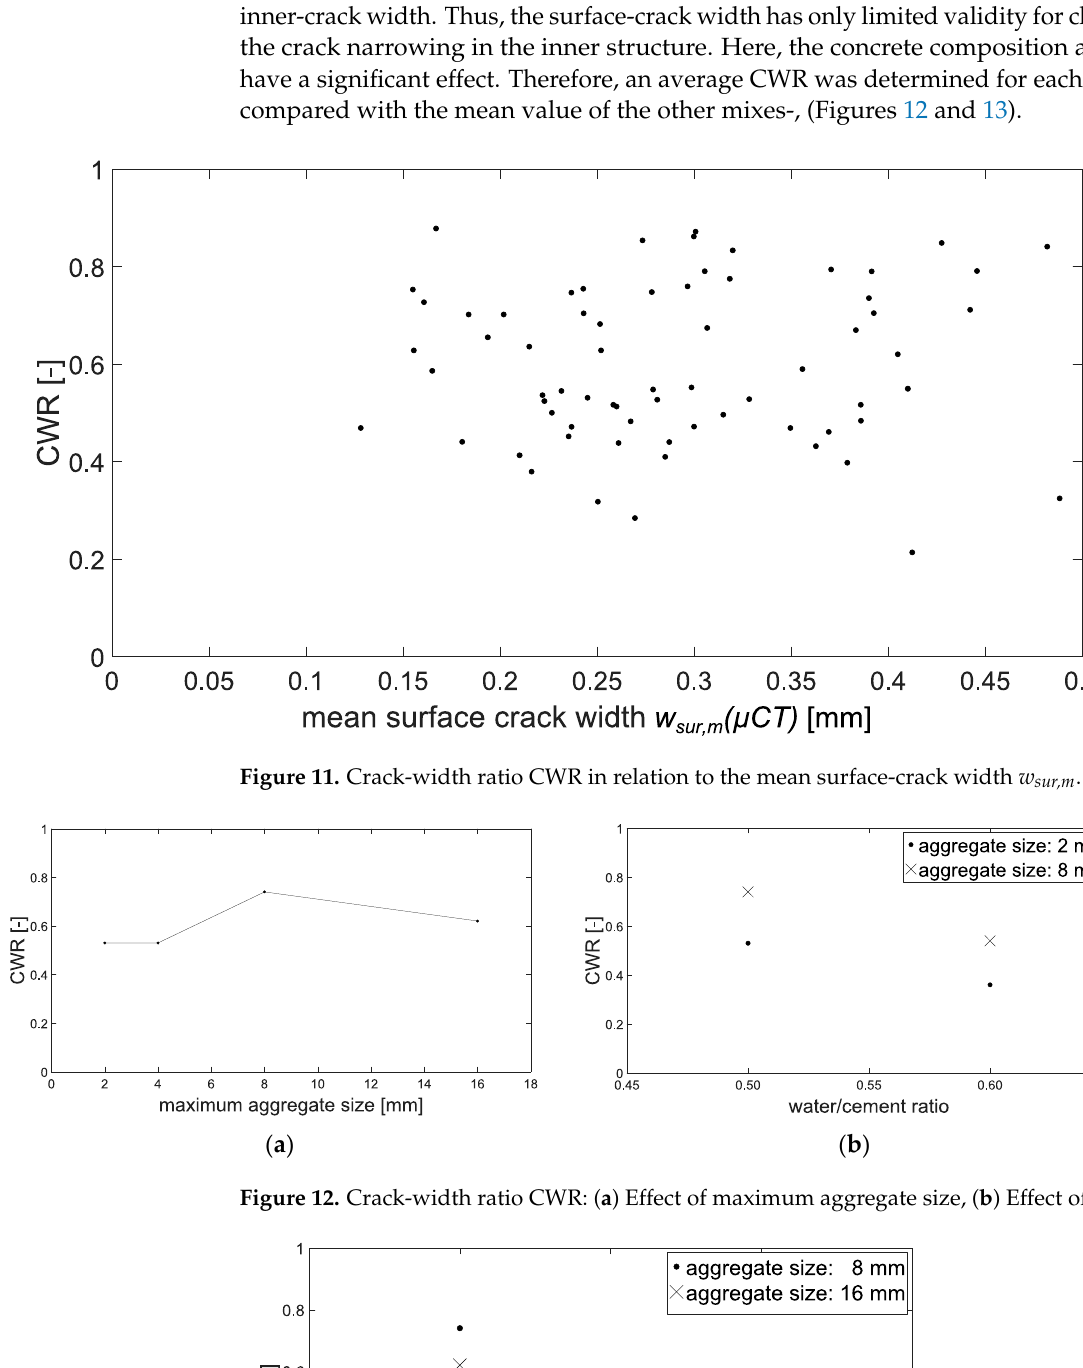
Figure 12. Crack-width ratio CWR: ( a ) Effect of maximum aggregate size, ( b ) Effect of w / c -ratio.